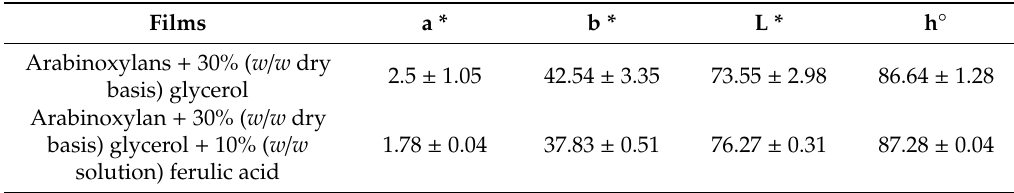
Table 5. Color experimental results for parameters a *, b *, L * and h.